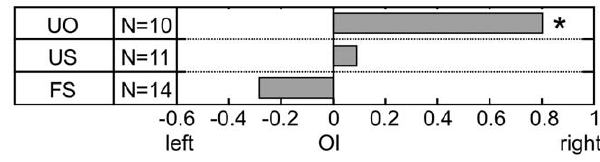
Figure 3. OI index, based on the first session. OI index on the population level, based on the responses towards the three different caller categories, i.e. unfamiliar sender of the other sex (UO) unfamiliar sender of the same sex (US), and familiar sender of the same sex (FS).